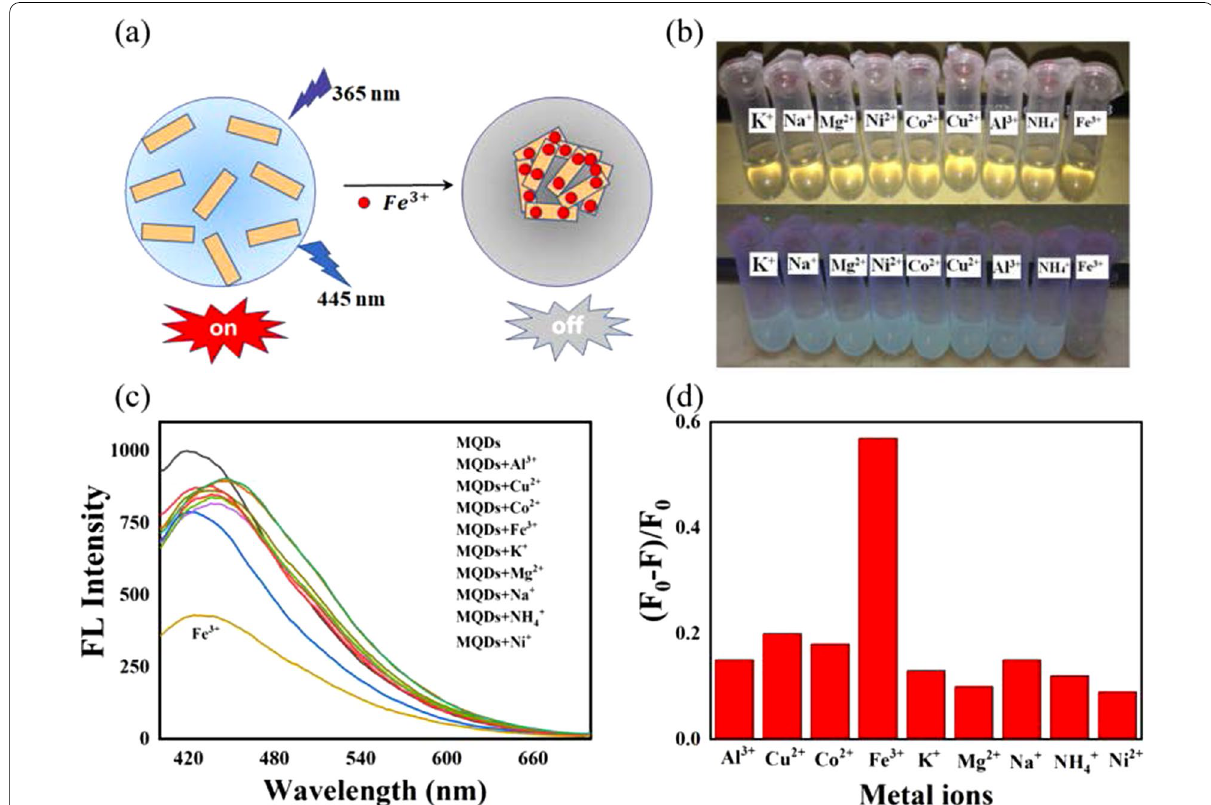
Fig. 5 a Schematic diagram for the fluorescence quenching mechanism of MQDs by ferric ions; b the picture for the MQDs solutions with the addition of different metal ions (0.8 mM) under the visible and ultraviolet light; c the fluorescent curves of MQDs solution with the different metal ions (0.8 mM); and d the fluorescent intensity change of MQDs toward different metal ions collected from the curves in ( c